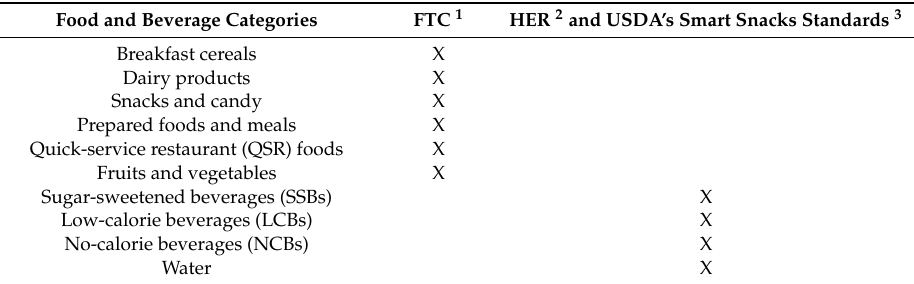
Table 1. Food and beverage categories in the celebrity